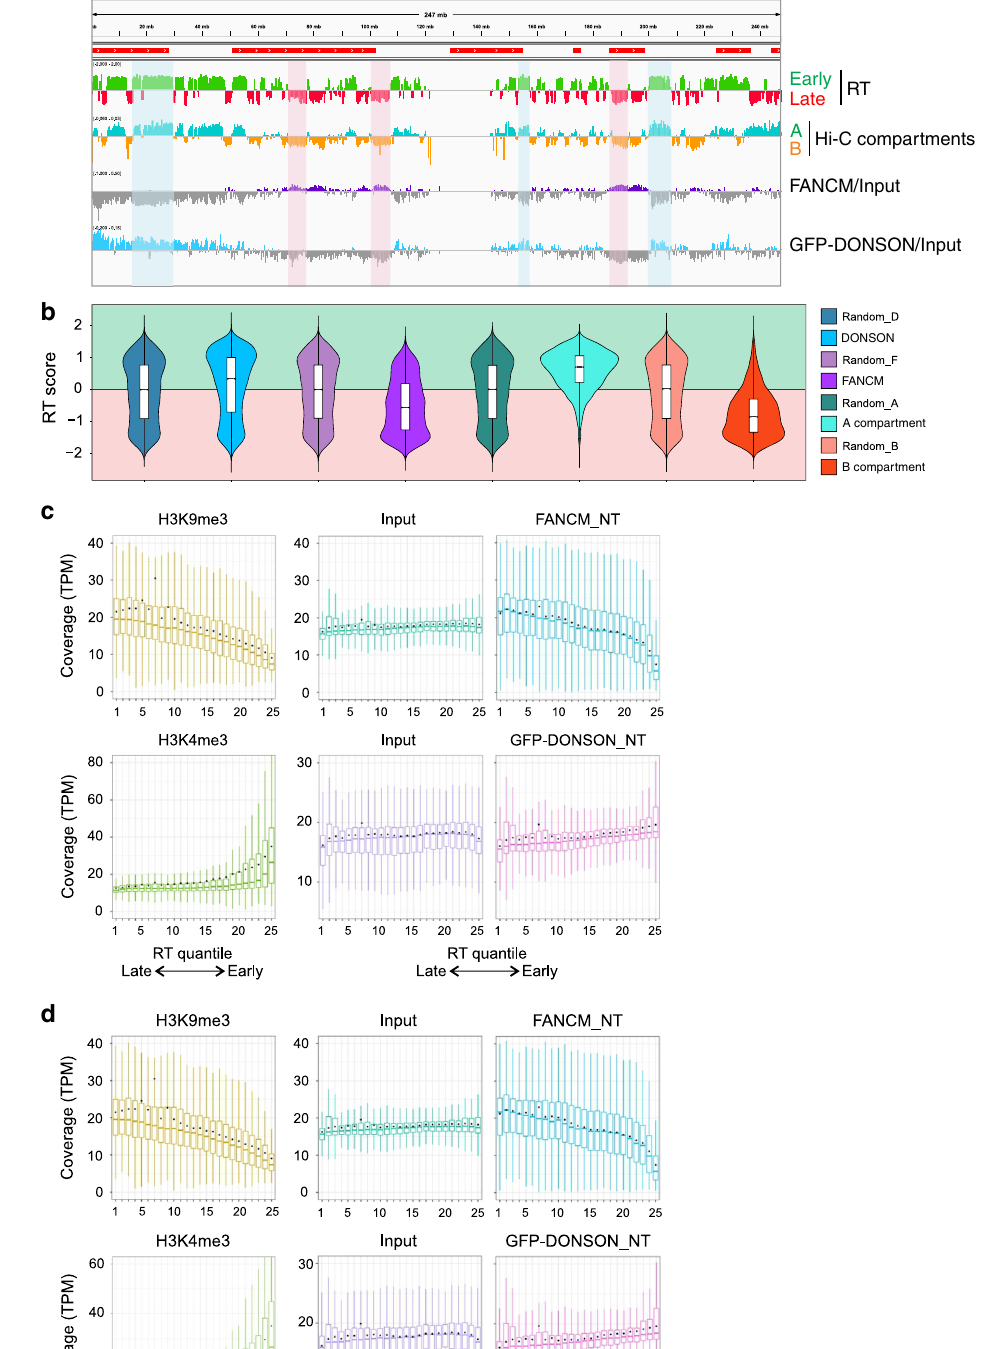
Cells derived from patient 9 with mutations in DONSON 24 , stably transduced with pMSCV-vector only or pMSCV-DONSON, were grown in DMEM (Gibco) supplemented with 10% fetal calf serum (Gibco), L -Glutamine (Gibco), 100 U/ mL penicillin, 100 μ g/mL streptomycin sulfate (Gibco). All cells were routinely tested for mycoplasma (Lonza, LT07-701). To determine the effect of knock- down of DONSON and FANCM in the DNA fi ber assay, HeLa cells were transfected with 10 nM siRNA (Dharmacon) using RNAiMAX (Invitrogen)